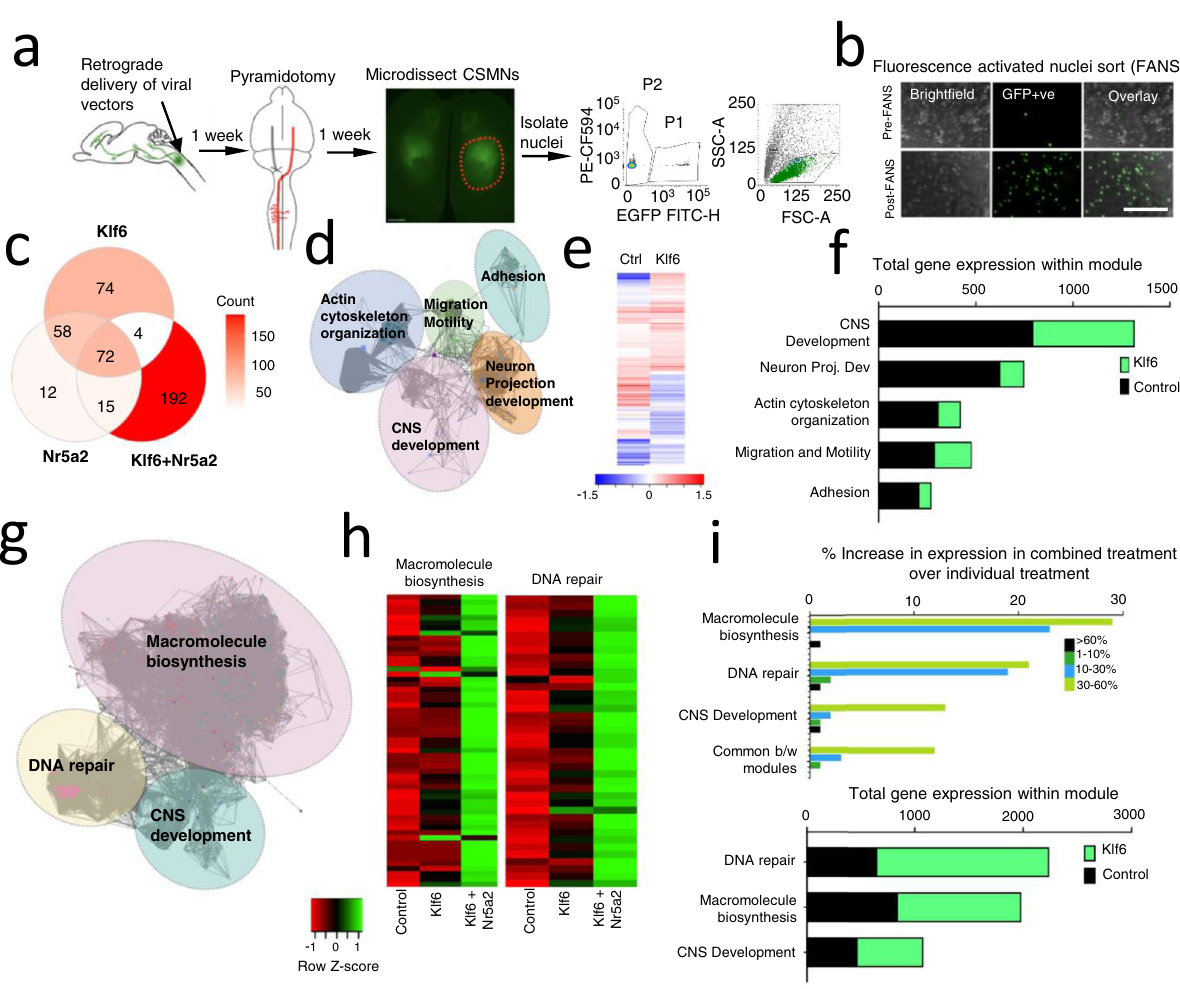
Fig. 7 Combined Klf6, Nr5A2 treatment induces expression of gene modules involved in macromolecule biosynthesis and DNA repair. a Overview of sample collection for RNA-Seq analysis. (CSMNs, corticospinal motor neurons). b Nuclei before and after FANS, con fi rming successful puri fi cation of mNeongreen + nuclei. c Venn diagram showing transcript comparison across the three gene treatments. d Regulatory network analysis of genes upregulated after Klf6 overexpression revealed subnetworks enriched for distinct functional categories highly relevant to axon growth. Nodes correspond to target genes and edges to multiple modes of interaction (physical, shared upstream regulators, shared signaling pathways, and inter-regulation). Only signi fi cantly enriched GO categories were included in the network analysis ( p < 0.05, right-sided hypergeometric test with Bonferroni correction, Cytoscape). e Heatmap showing selection of differentially expressed genes between control and Klf6 treatment. f The number of genes within each functional subnetwork (top) and the total FPKM values in each in control and Klf6 overexpression groups. g Regulatory network analysis of genes uniquely upregulated after combined Klf6 and Nr5a2 overexpression (not upregulated in single treatments) revealed subnetworks enriched for functions in macromolecule biosynthesis and DNA repair ( p < 0.05, right-sided hypergeometric test with Bonferroni correction, Cytoscape). h Heatmap showing selection of differentially expressed genes in DNA repair and macromolecule biosynthesis modules. Genes that are upregulated (green) and downregulated (red) relative to control are shown. Color values indicate average FPKM expression values as shown in the legend. Columns correspond to treatment groups and rows to genes. i The percent change in FPKM values within each module, revealing that combined Klf6 and Nr5a2 treatment most affect genes in DNA repair and macromolecule biosynthesis modules (top). Graph shows the number of genes within functional subnetworks (bottom). n = 3 animals pooled per replicate, 2 replicates/gene treatment with similar results (Supplementary Data 4). Scale bar is 100 µ m. Source data are provided as a Source Data fi le. To further validate the fi ndings of this bulk RNA sequencing clusters highly enriched for established markers of CST neurons, (RNA-Seq) approach, we performed a replicate study, this time including Bcl11b, Cdh13, Tmem163, Crim1, Cntn6, and Slco2a1, employing a single-nuclei RNA-Seq approach. Nuclear-localized indicating successful puri fi cation of CST neurons 23,37,38 (Supple- fl uorophores and TFs (Control or Klf6 + Nr5a2) were expressed mentary Fig. 8c). We integrated control and K fl 6/Nr5a2 single- nuclei datasets using SEURAT 39 , and carried out differential gene by cervical injection of Retro-AAV2 as described above expression analyses to identify Klf6/Nr5a2-responsive target (Supplementary Fig. 8a) Animals received pyramidotomy injury, genes, speci fi cally in the high-con fi dence CST cluster (Supple- followed 1 week later by puri fi cation of labeled nuclei of CST mentary Data 4). As expected, Klf6 and Nr5a2 themselves were neurons by fl ow cytometry, construction, and sequencing of detected as strongly upregulated. In addition, when comparing single-nuclei libraries. Using this approach, we sequenced and the output of the initial bulk RNA-Seq and single-nuclei RNA- analyzed ~3000 control nuclei and Klf6/Nr5a2-treated nuclei Seq, 144 genes were commonly called as signi fi cantly regulated by (Supplementary Fig. 8b). The majority of nuclei partioned into NATURE COMMUNICATIONS| (2021) 12:2555